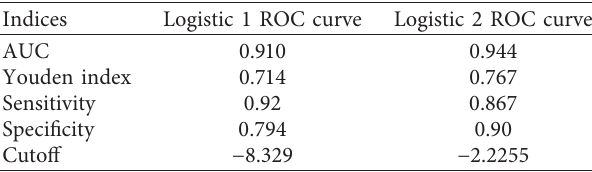
Table 5: Index analysis of Logit (1) and Logit